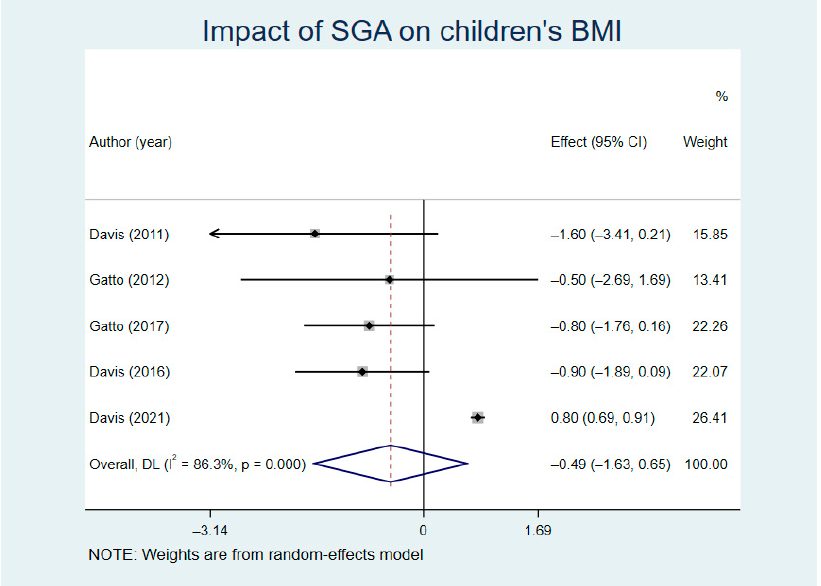
Figure 5. Impact of school gardening activities (SGA) on children’s body mass index (BMI).